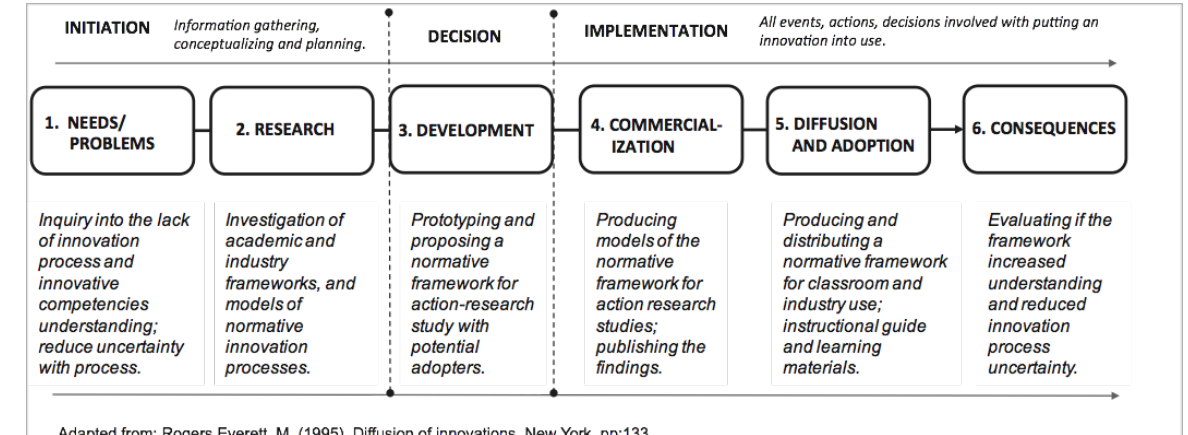
Fig. 4. Adaptation of E. Rogers’ innovation development process for this normative fra-